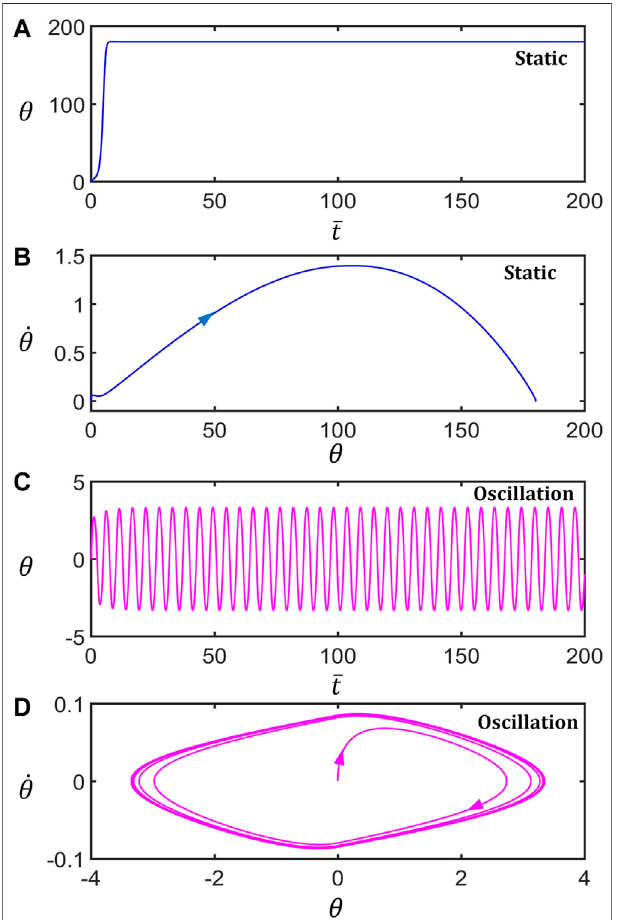
FIGURE2| Twomotionmodesofthelight-poweredinvertedpendulum. (A) and (C) are the time series curves of the unstable static mode ( θ 1 (cid:2) 50 ° ) and self-stabilized oscillation mode ( θ 1 (cid:2) 70 ° ) , respectively. (B) and (D) are phase diagrams of the unstable static mode and self-stabilized oscillation mode, respectively. The other parameters are (cid:2) I (cid:2) 0 . 25, C 0 (cid:2) 0 . 4, (cid:2) g (cid:2) 9 . 8, (cid:2) ζ (cid:2) 14 . 7, θ (cid:2) 0 ° , and _ θ (cid:2) 0. 0 0